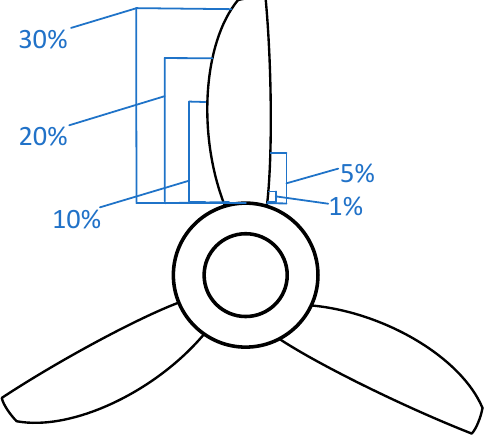
Figure 6. Single blade with different degrees